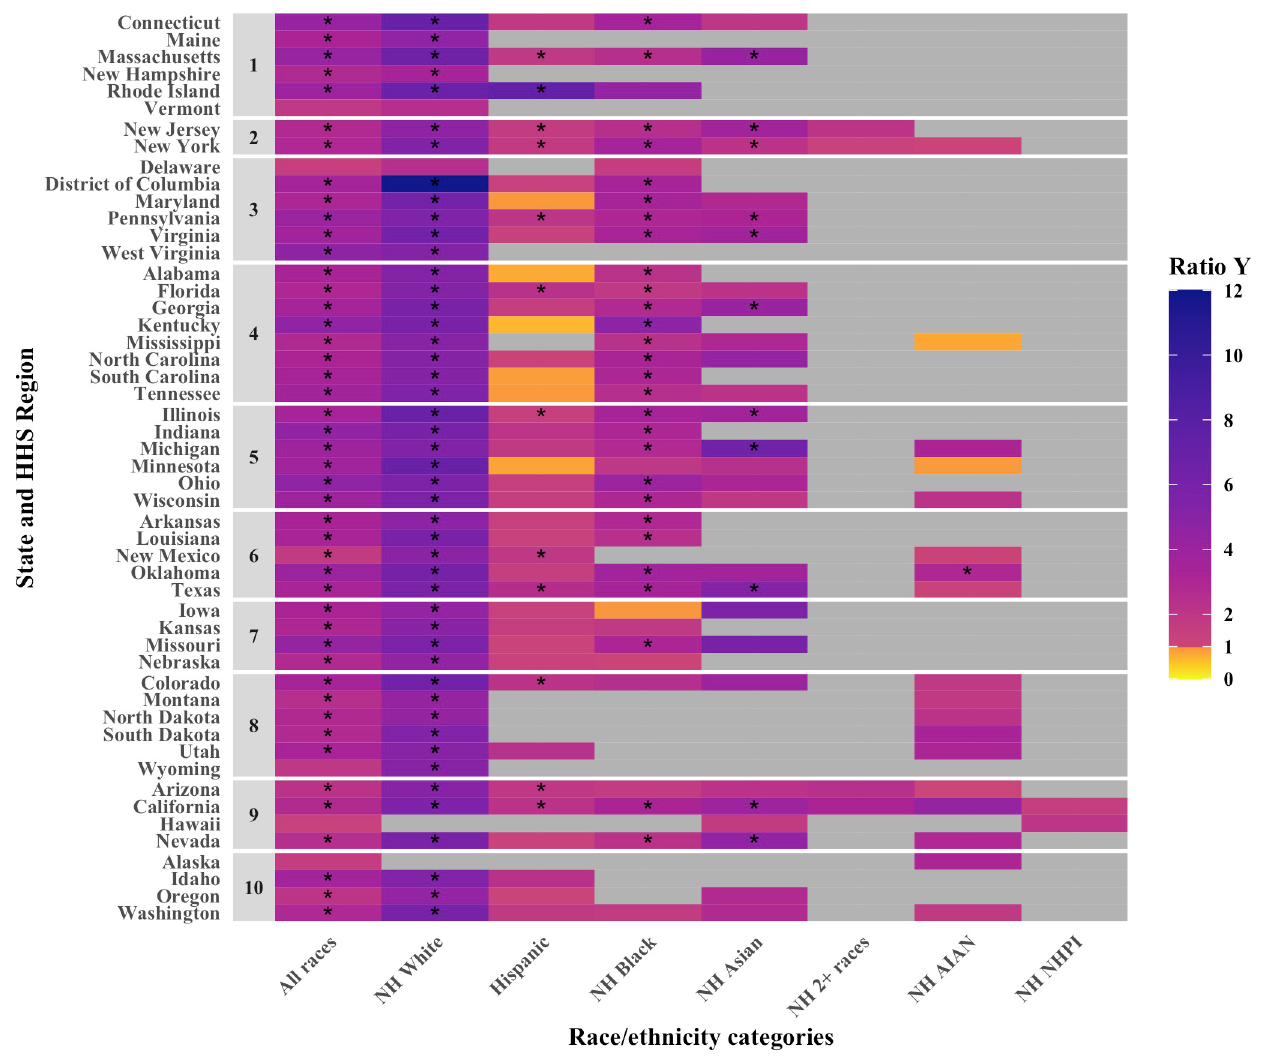
Fig 2. Comparative performance of policies S and F (shown in the form of a ratio Y = YS j of Columbia in terms of years of life saved. States are grouped by HHS Region. Stars indicate the race/ethnicity/state for which the lower bound of the 95% interval did not include